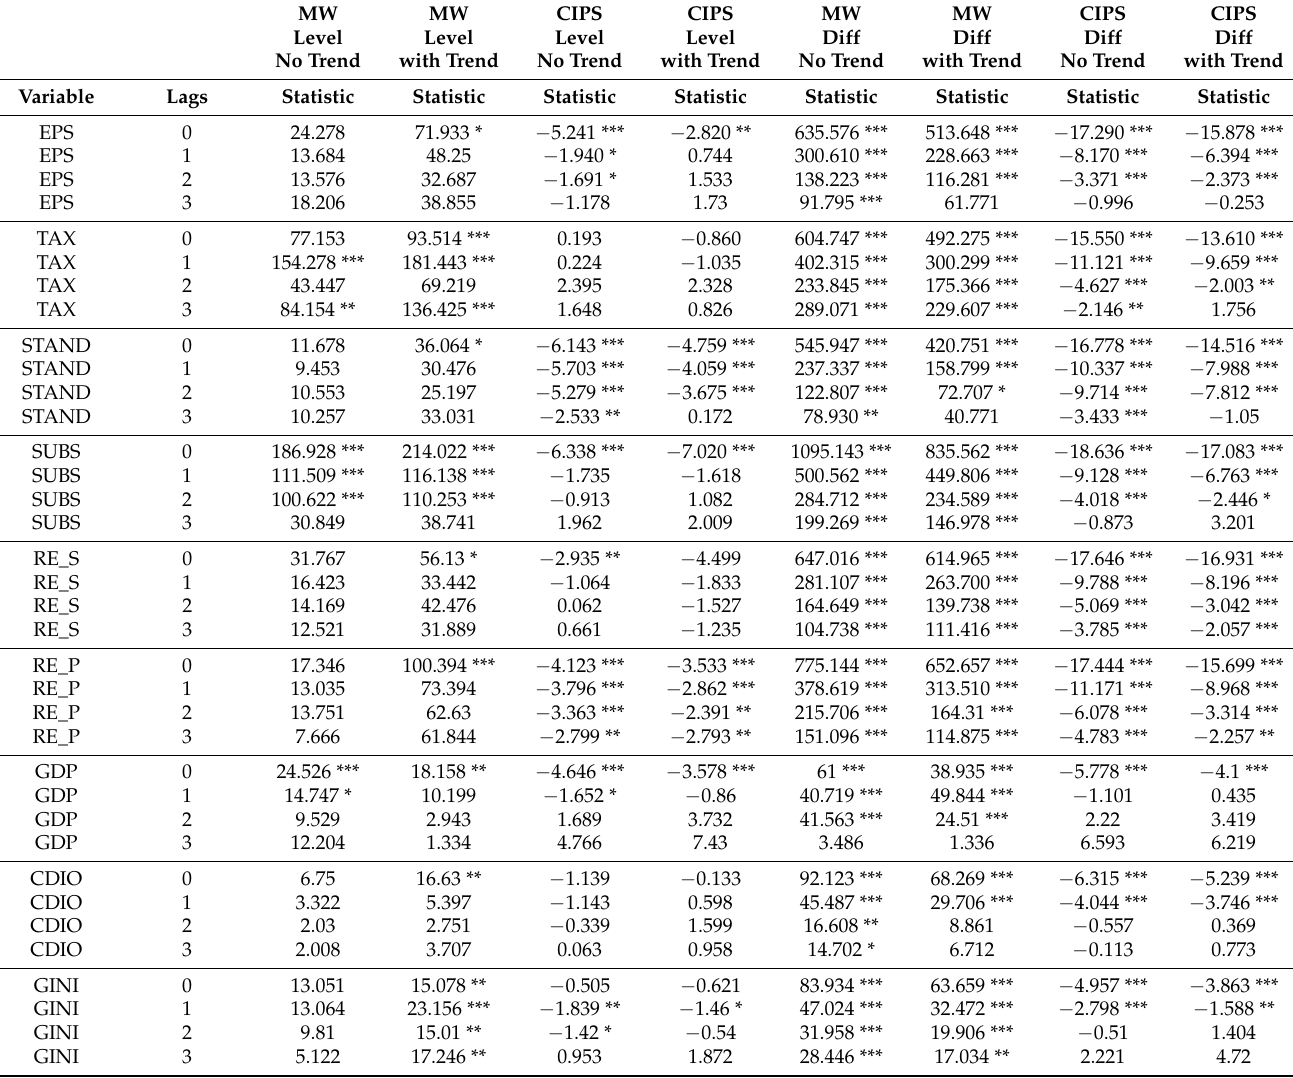
Table 7. Second generation of unit root